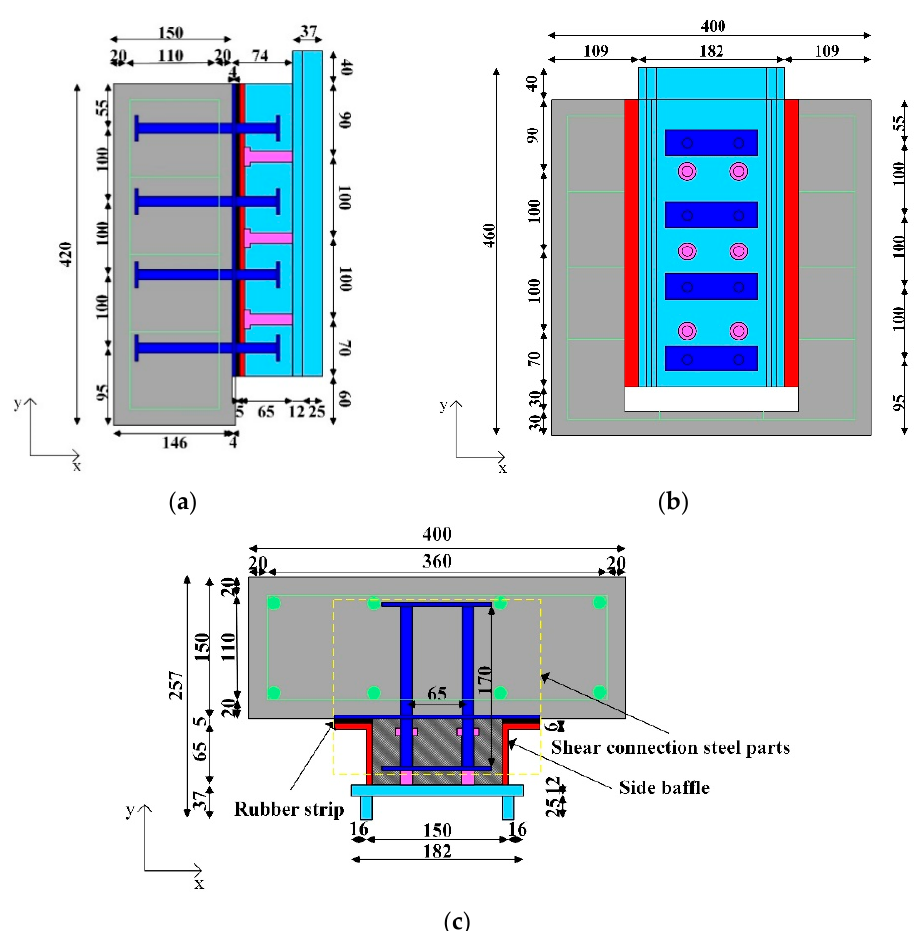
Figure 3. Details of specimens: ( a ) Front view; ( b ) Side view; ( c ) Top view. (Unit: mm).